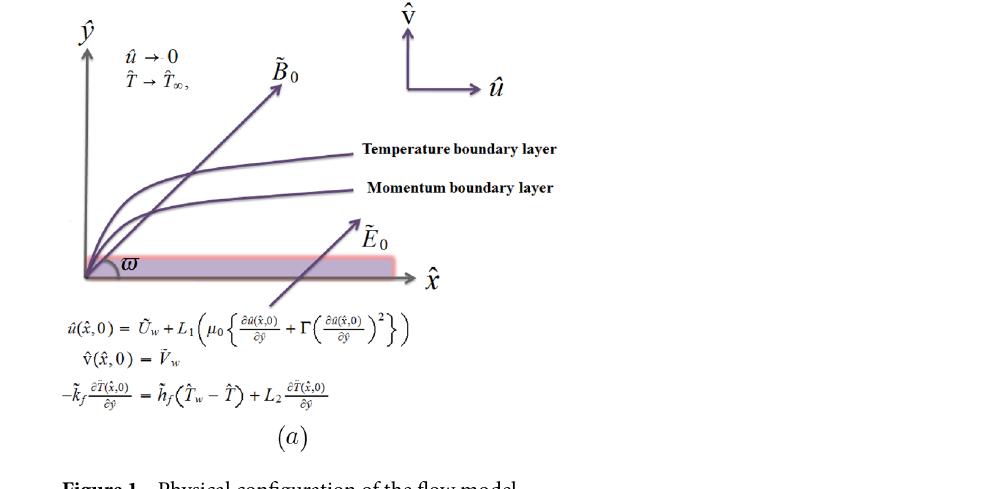
Figure 1. Physical configuration of the flow